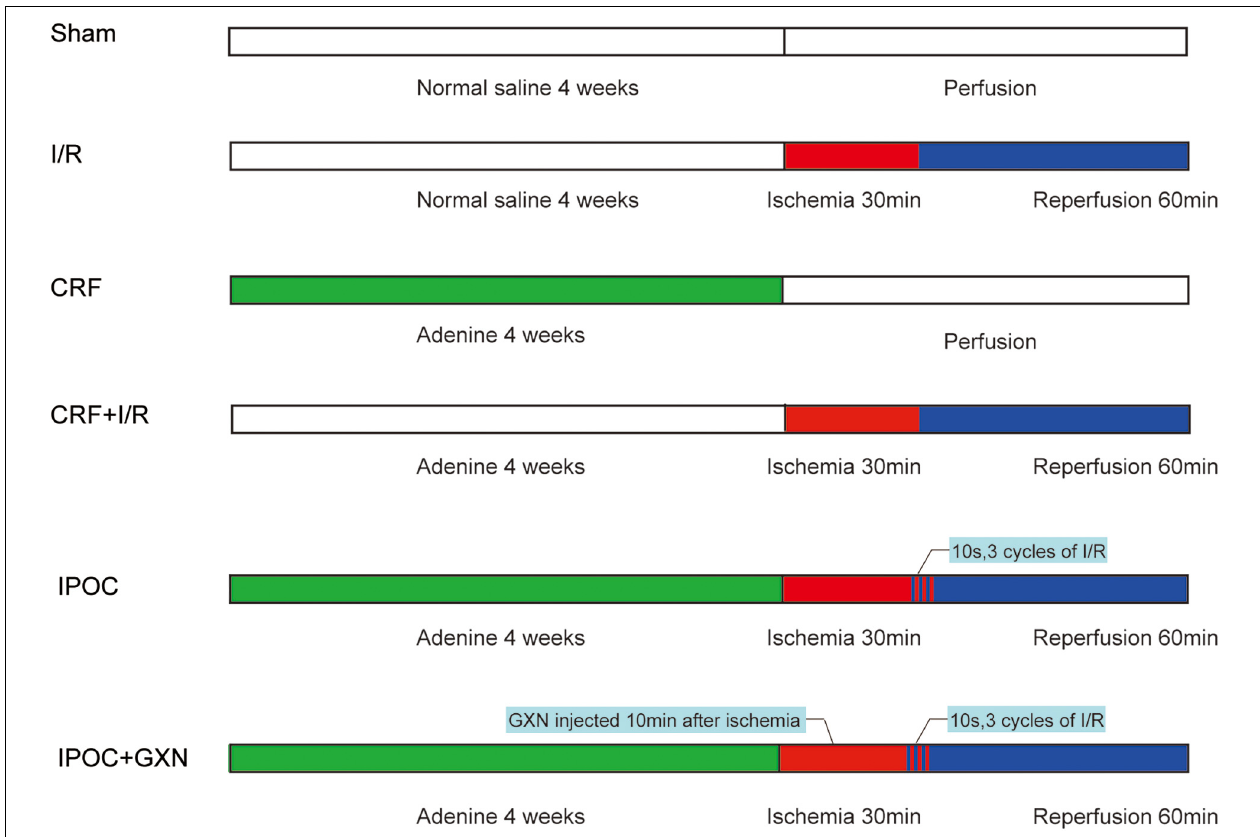
FIGURE 1 | Experimental protocol. The rats were given adenine daily for 4 weeks to establish the CRF model. Then the rats underwent a 30 min ischemia procedure, followed by 60 min of reperfusion. After 30 min of ischemia, the rats were immediately given 3 cycles of reperfusion and ischemia (reperfusion: the suture line was relaxed for 10 s, ischemia: the suture line was tightened for 10 s). The GXN is injected into the iliac vein 10 min after ischemia. The sham-operated group was given an equal amount of normal saline and underwent a procedure without ischemia, but it was time-matched. Sham, sham-operated group; I/R, ischemia/reperfusion injury group (no CRF); CRF, chronic renal failure group (no I/R injury); CRF + I/R, comorbid model group; IPOC, comorbid model rat was treated with ischemic postconditioning; IPOC + GXN, the Guanxinning injection was injected in rats of the IPOC group after 10 min of ischemia.